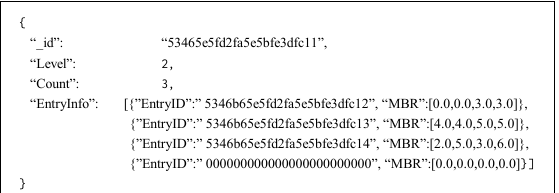
Figure 1. An example of R-tree node document